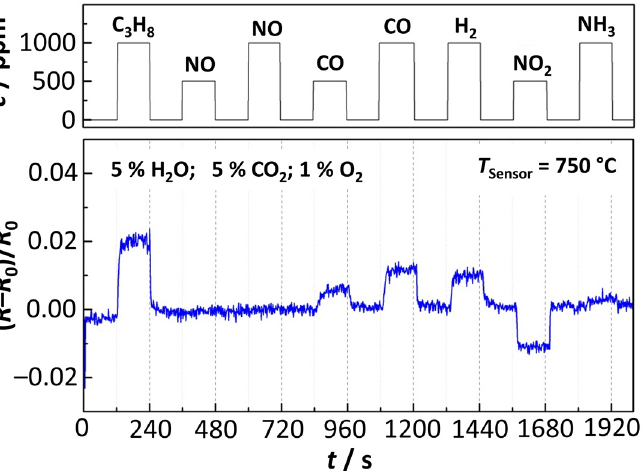
Figure 8. Effect of pollutant concentration on the (relative) sensor resistance of the BFAT film at a sensor temperature of T Sensor = 750 °C (sensor B).